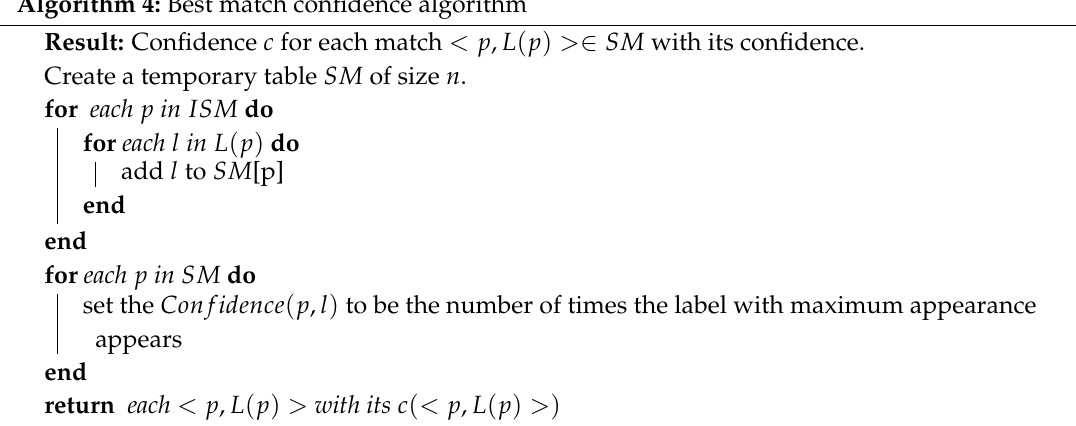
Algorithm 4: Best match confidence algorithm